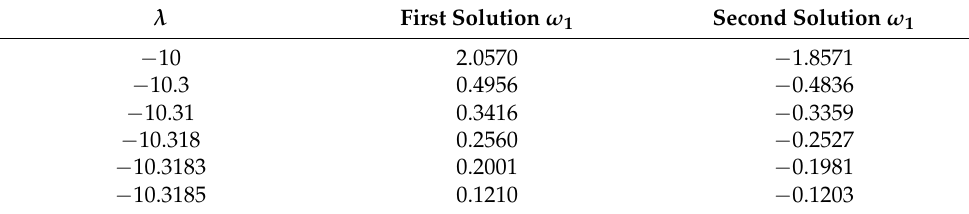
Table 5. The smallest eigenvalues ω 1 with assorted λ .